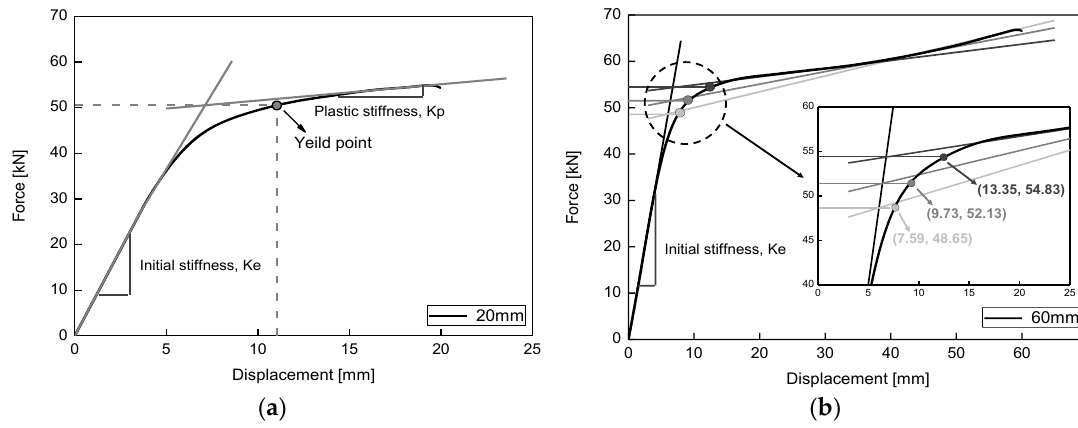
Figure 8. Use of the TI method to calculate the yield point: ( a ) ± 20 mm; ( b ) ± 60 mm.